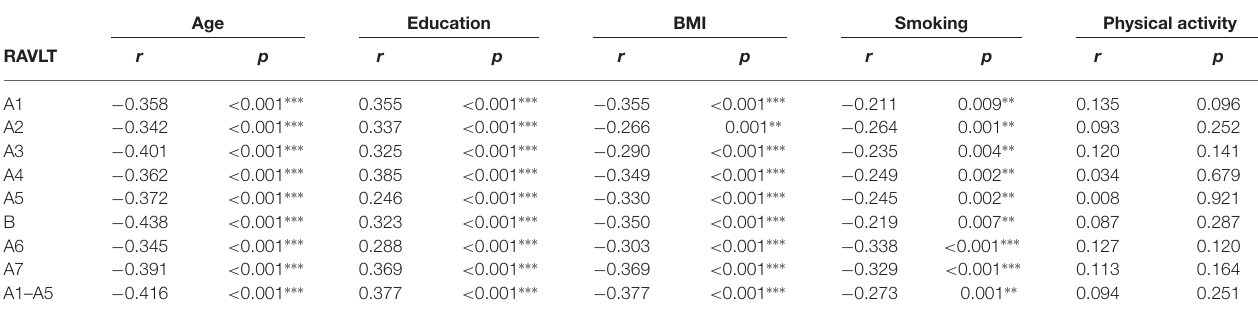
TABLE 3 | Pearson’s correlations of RAVLT results with sociodemographic and lifestyle variables ( N = 152). Age Education